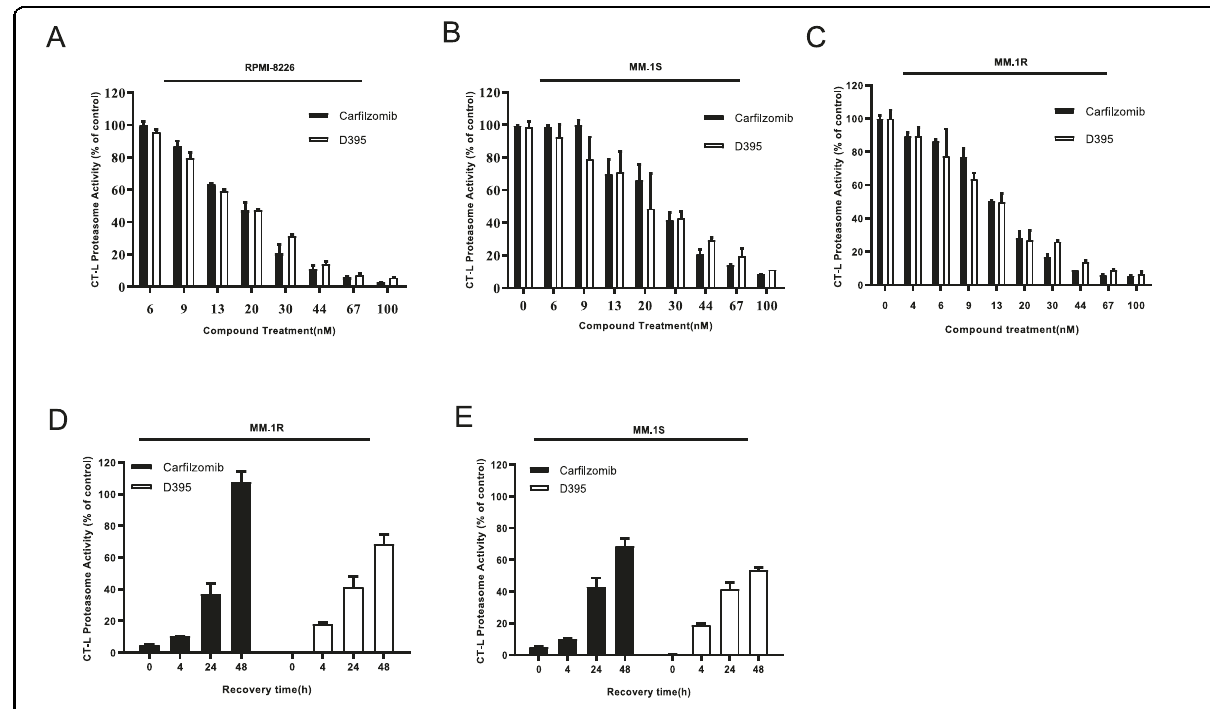
Fig. 1 Inhibition and recovery of proteasome activity in MM cell lines. A – C Inhibition of cellular proteasome activity following D395 and car fi lzomib treatment for 24 h. D , E Recovery of cellular proteasome activity following D395 and car fi lzomib treatment. Proteasome chymotrypsin-like activity was measured in lysates prepared from RPMI-8226, MM.1S and MM.1R cells at the indicated time following exposure to various concentrations of D395 or car fi